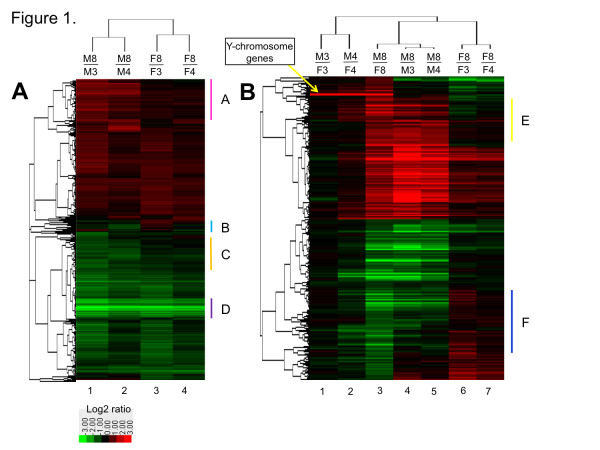
Heat maps displaying patterns of expression for 5,715 regulated genes clustered by gene and sample. Genes are depicted based on their expression ratios across the seven microarray experiments. Colors range from bright red (up regulation, log2 ratio ≥ 3) to bright green (down regulation, log2 ratio ≤ -3). Hierarchical clustering was performed based on Pearson's correlation of log2 ratios. The dendograms at the top identify arrays showing the greatest similarity in their patterns of expression. M3, male liver at 3 wk; M4, male liver at 4 wk; M8, male liver at 8 wk; F3, female liver at 3 wk; F4, female liver at 4 wk; and F8, female liver at 8 wk. A. Heat map showing expression ratios for 4,503 adult sex-independent genes in the four microarray comparisons indicated at the top. Qualitative differences between sexes were seen in the developmental changes for the gene groups marked A-C at the right: group A genes showed greater up regulation in male liver than in female liver, group B genes showed greater up regulation in female liver than in male liver, and group C genes showed greater down regulation in male liver than in female liver. Group D genes showed strong down regulation in both sexes from 3 or 4 wk to 8 wk and includes genes associated with cell cycle and mitosis. B. Heat map showing expression ratios for 1,212 adult sex-specific genes across the seven microarray comparisons indicated at the top. Marked at the right are genes in group E, which show developmental up regulation from 3 or 4 wk to 8 wk in male liver but not in female liver, and genes in group F, which show developmental up regulation in female liver and down regulation in male liver.